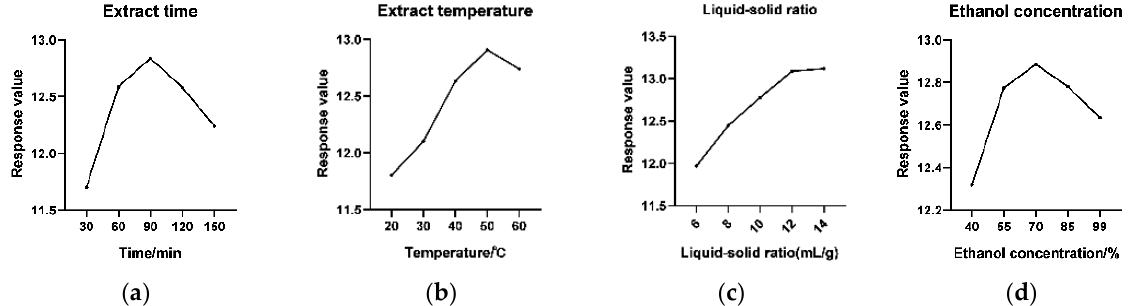
Figure 2. Single-factor experimental results of Yuanzhi extraction process. ( a ) Effect of extract time. ( b ) Effect of extraction temperature. ( c ) Effect of extraction liquid–solid ratio. ( d ) Effect of extraction ethanol concentration.